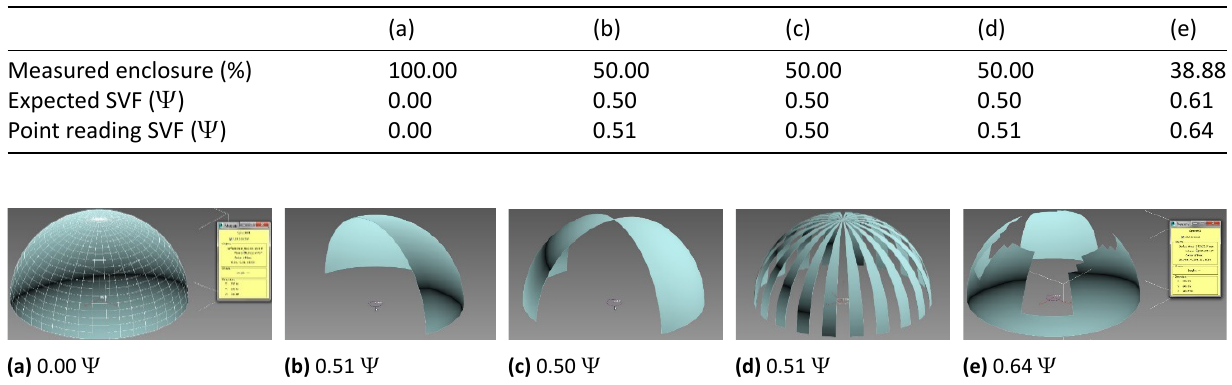
Figure 5. This figure gives examples of part of verification testing showing a 300m radius dome with known surface area compared with domes of the same radius but different percentages of surface area removed, measuring each with single SVF meter (in the central point of the dome).